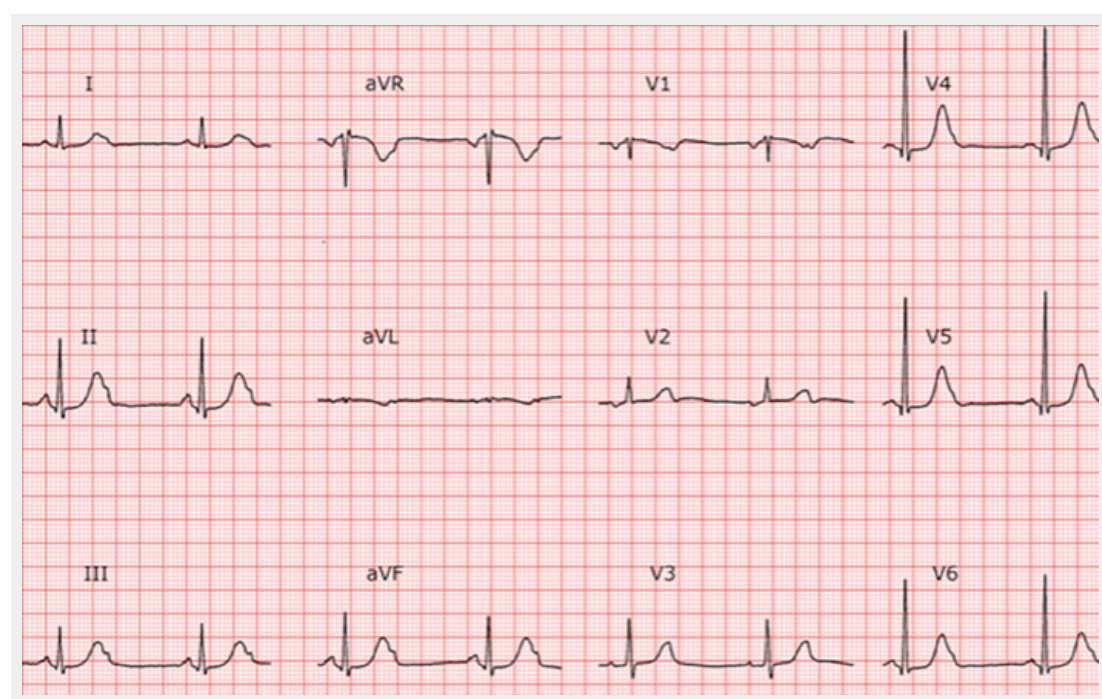
One ECG from the survey. Description and MCQ are provided before voting. Diagnosis and comments are given after the vote. Description: Basic rhythm: sinus rhythm, regular at 50 bpm. P waves: normal, but every second wave is blocked. PR interval: normal. QRS: normal duration, increased amplitude from V4 to V6, normal axis. ST segment: isoelectric. T waves: normal. QT interval: prolonged (510 ms). MCQ: